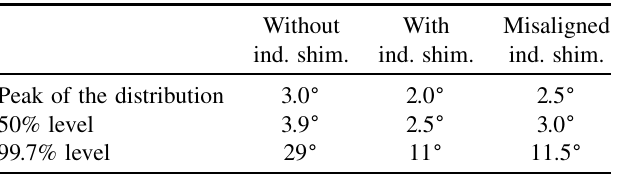
Without With Misaligned ind. shim. ind. shim. ind. shim.